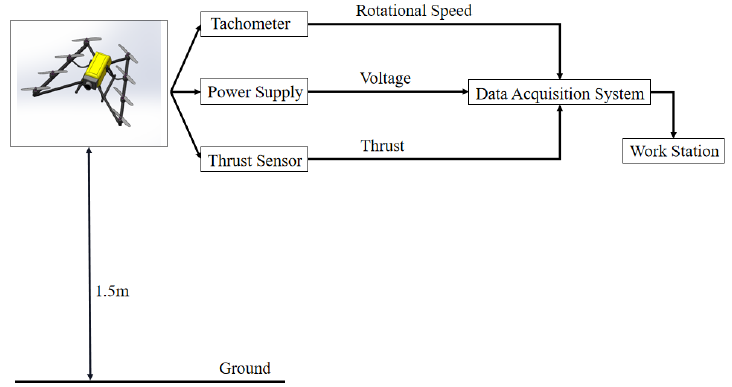
Figure 3. Sketch of the experimental setup.